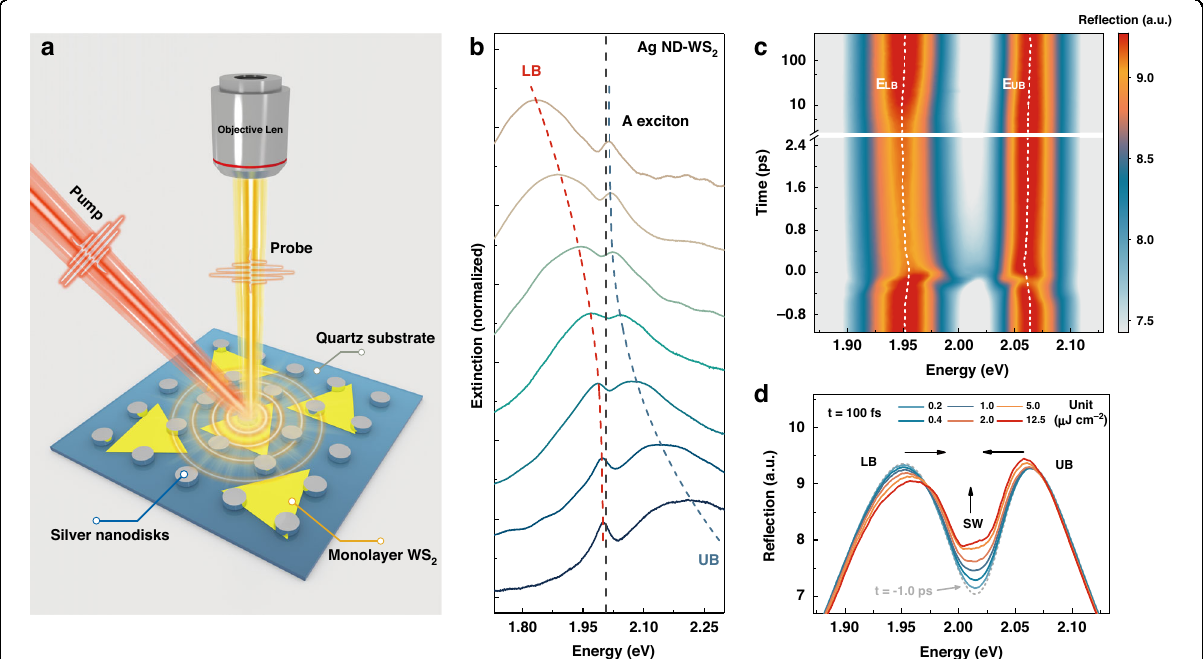
Fig. 1 Ag ND – WS 2 plexcitonic system and its steady-state/ultrafast optical properties. a Schematic illustration of the Ag ND – WS 2 hybrid system, in which time-resolved pump – probe microscopy was adopted to study its ultrafast optical responses. b Normalized extinction spectra of the Ag ND – WS 2 hybrid system with increasing disk diameter (from bottom to top) in the range of 80 – 140 nm, with an increment of ~10 nm. The red and blue dashed lines represent the UB and LB of plexcitons, respectively, and the black dashed line indicates the exciton resonance location. c Time- resolved re fl ection spectra scan of the zero-detuning (disk diameter of 110 nm) Ag ND – WS 2 plexcitonic system under 2.0 eV pump excitation conditions at an incident fl uence of 5 µJ cm − 2 . The inserted white dashed line indicates the peak energy evolution of UB and LB plexcitons as a function of time. d Re fl ection spectra of the Ag ND – WS 2 plexcitonic system projected from the cross-section of ( c ) at t = 100 fs. From bottom to top, the incident fl uence increases from 0.2 µJ cm − 2 to 12.5 µJ cm − 2 . The grey dashed line is the probe re fl ection spectrum at − 1 ps, which is unaffected by the pump